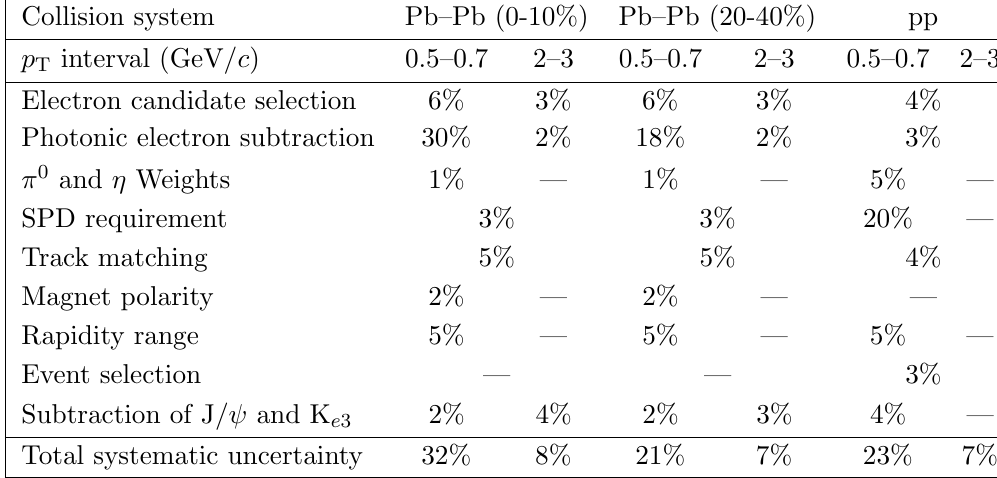
Table 5 . Contributions to the systematic uncertainties on the yield of electrons from semileptonic heavy-(cid:13)avour hadron decays, quoted for the lowest and highest p T interval, respectively.